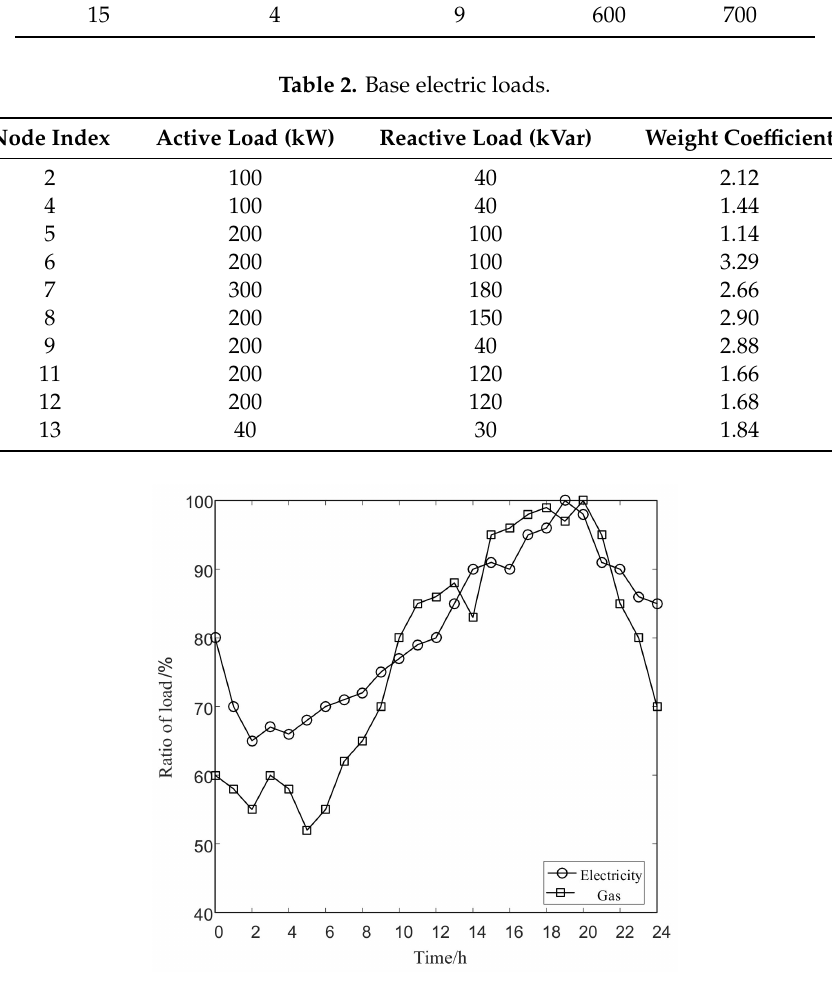
Figure 10. Load curve in one